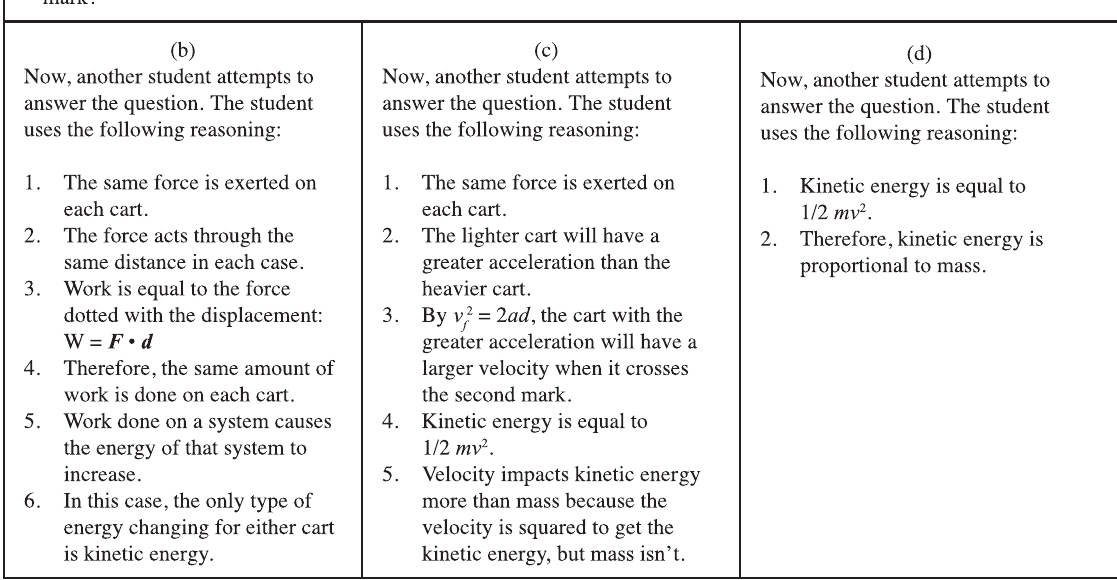
FIG. 1. Follow task 1, the work and kinetic energy follow task. The base task is shown in (a). The reasoning chain shown in (b) is correct and supports the correct conclusion that the kinetic energy of cart A will be equal to cart B after the carts pass the second mark. The reasoning chain shown in (c), the v - wins chain , supports the conclusion that the kinetic energy of cart A will be greater than the kinetic energy of cart B. The reasoning chain shown in (d), the mass-only chain , supports the conclusion that the kinetic energy of cart A will be less than the kinetic energy of cart